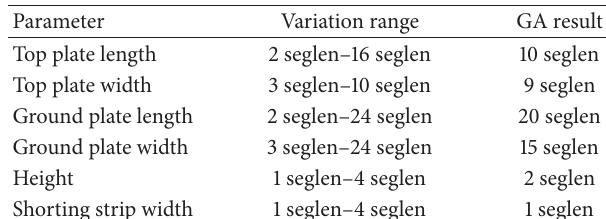
Table 1: Input parameters and results of the GA optimization pro- cedure for the